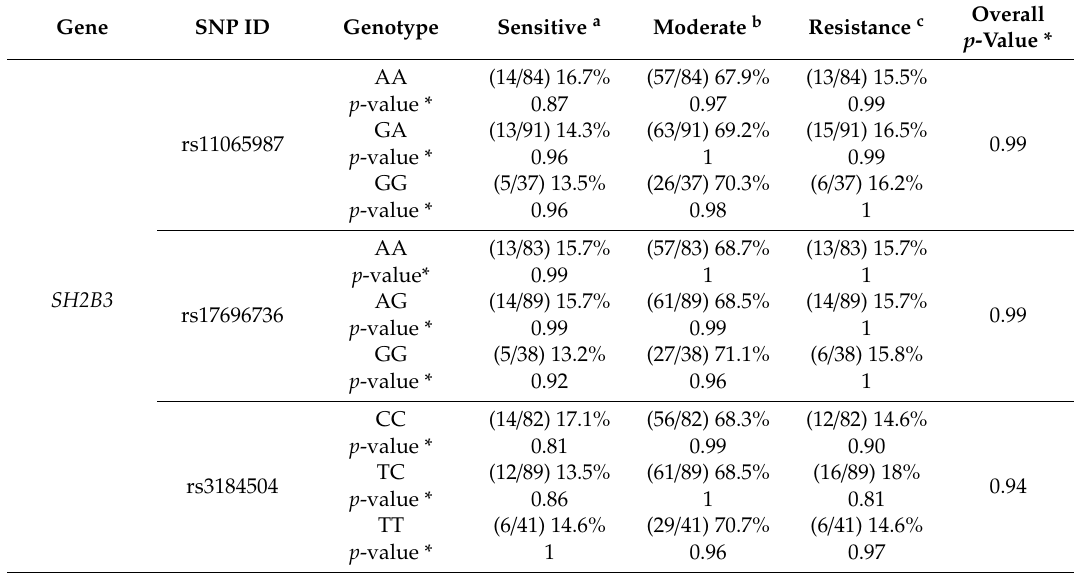
Table 2. Association of SH2B3 and MTHFD1L SNPs with warfarin sensitivity during the initiation phase of therapy of 212 cardiovascular patients treated with